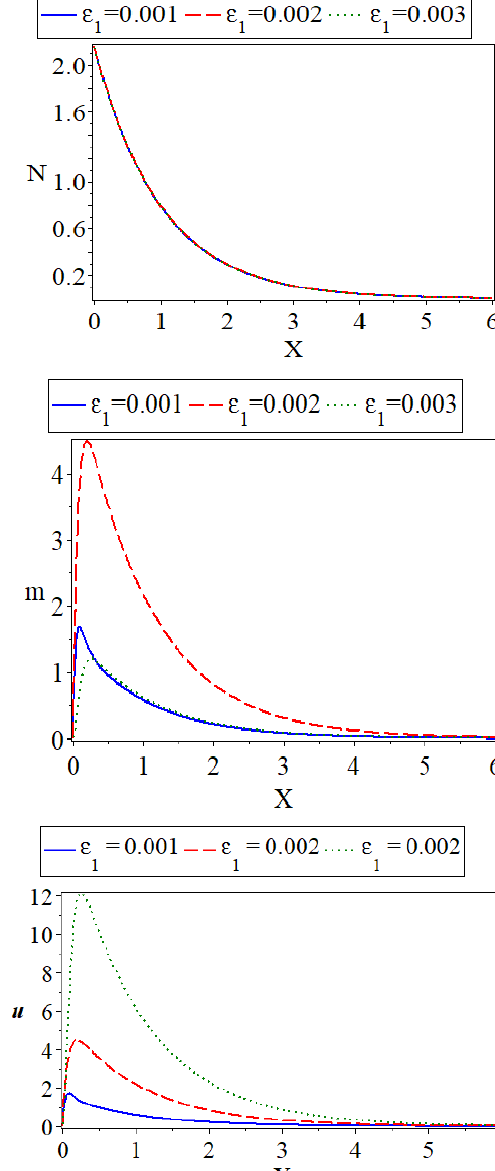
0 . 0 01 , 7 . 81 0  − ==− for Silicon (Si) material. Three cases of reference moisture 13